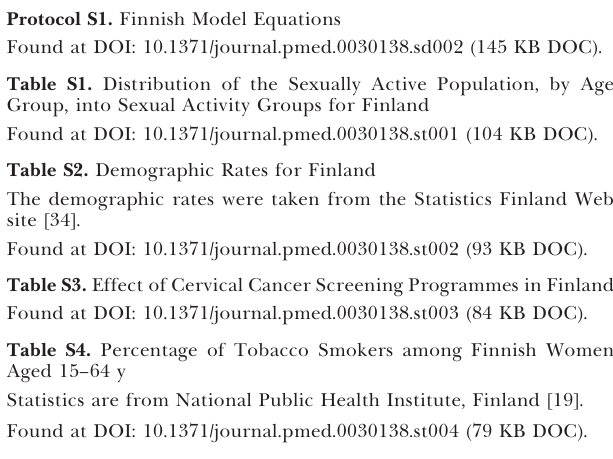
Figure S5. Effect of Changes in Sexual Behaviour